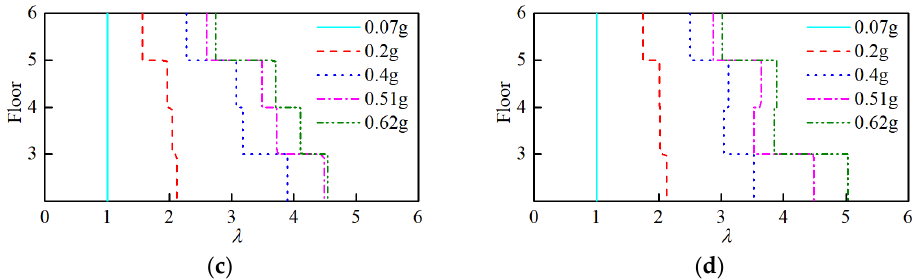
Figure 10. The 𝜆 of column across the slope direction: ( a ) Axis 1; ( b ) Axis 2; ( c ) Axis 3; ( d ) Axis 4.